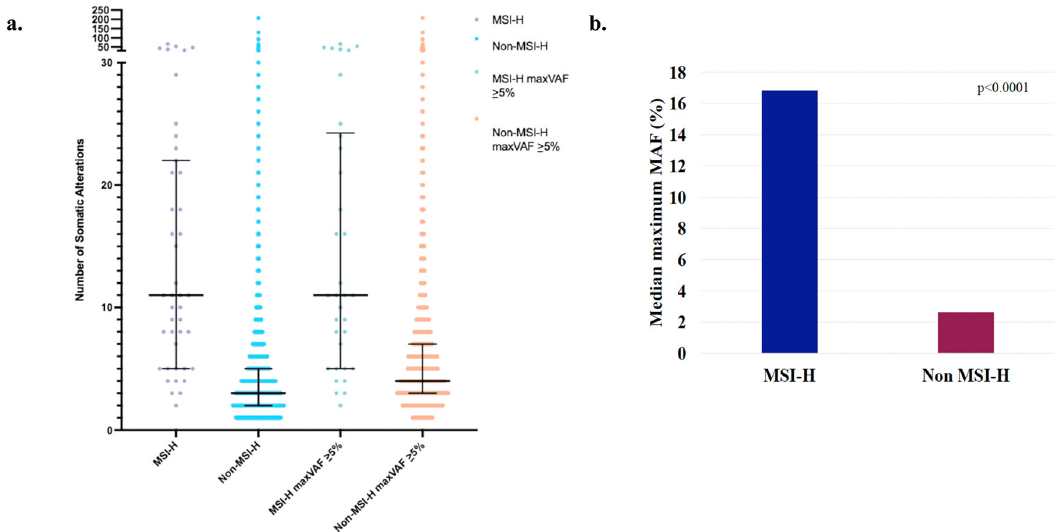
Fig. 1 Comparison of the number of somatic alterations and medium maximum MAF in MSI-H versus non-MSI-H samples. a Distribution of the number of somatic alterations detected per sample, including synonymous variants and variants of uncertain signi fi cance, excluding ampli fi cations, in MSI-H versus non-MSI-H samples. The number of somatic alterations in individual samples is represented by colored dots with median value and interquartile range outlined in black. b Median maximum MAF in MSI-H versus non-MSI-H samples (Mann – Whitney U - test p <